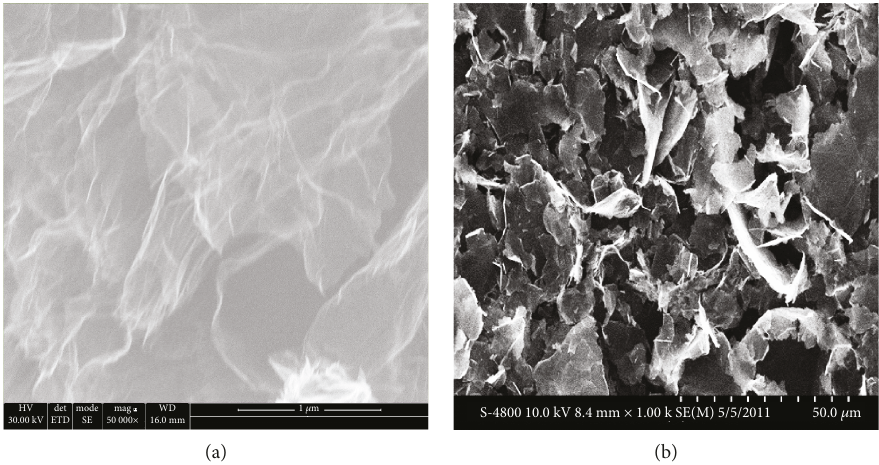
Figure 2: SEM microphotographs of (a) thermally reduced graphene oxide (RGO) and (b) graphene nanoplatelets